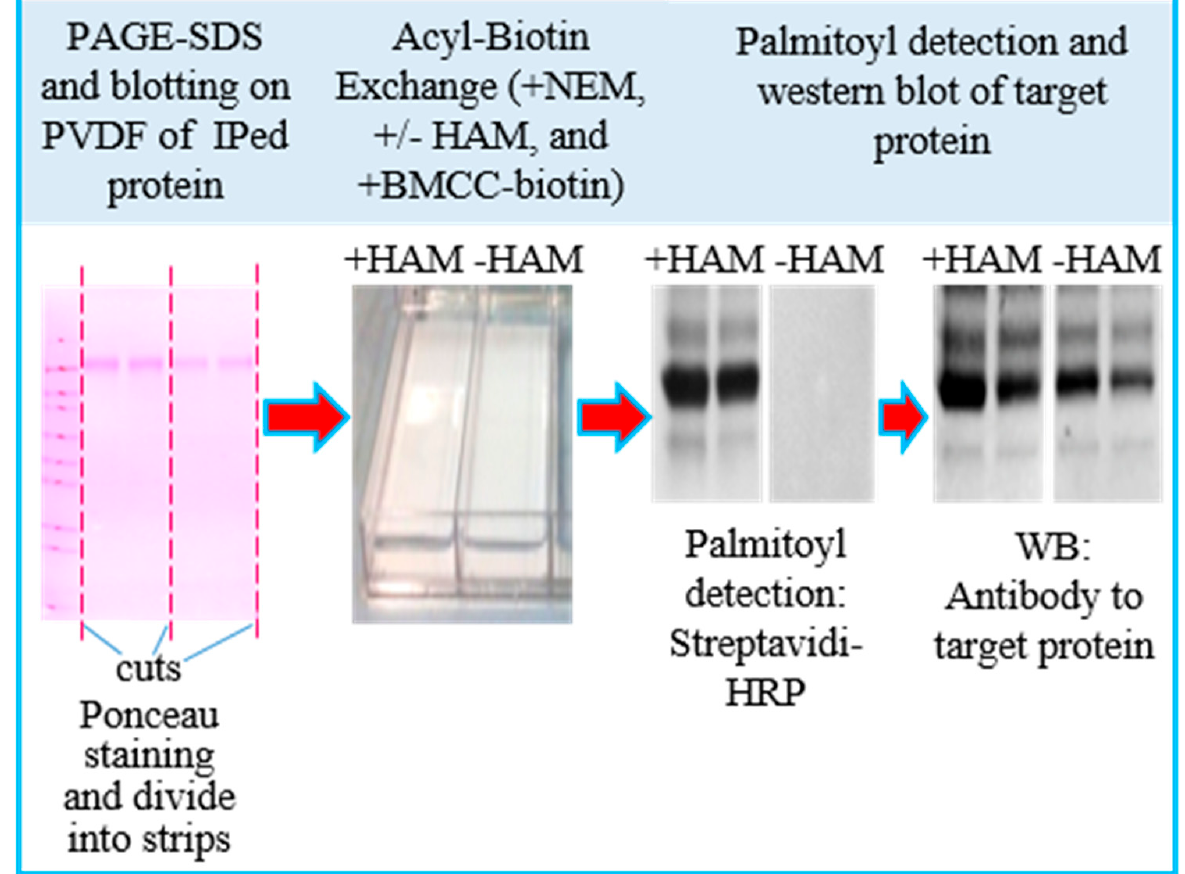
Figure 1. Schematic diagram of the ABE procedure.